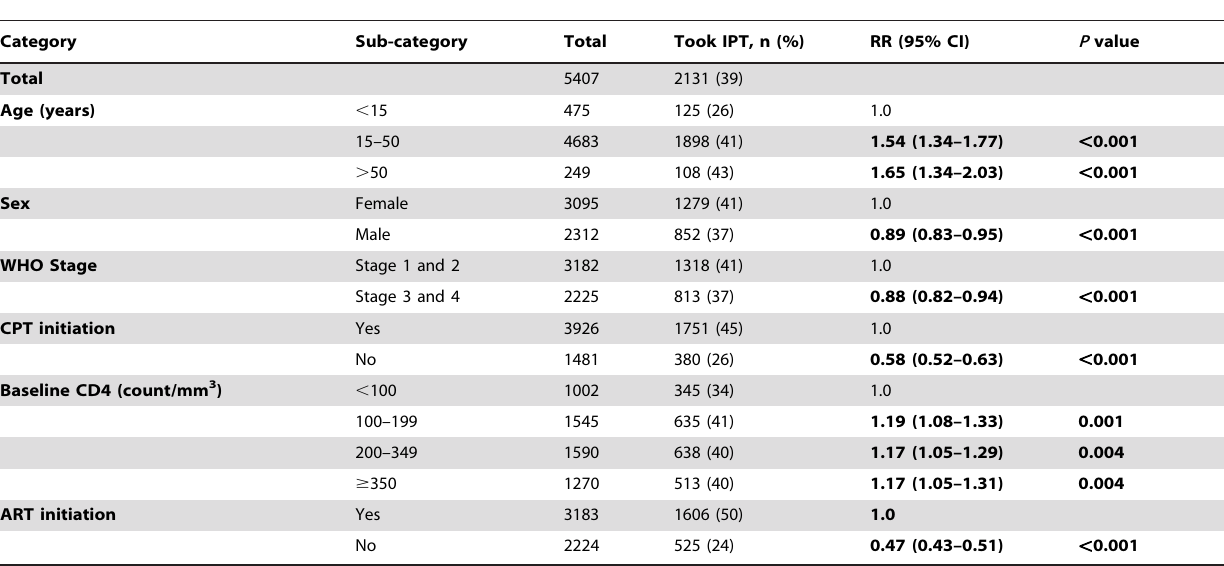
Table 2. Characteristics of HIV infected patients in Chronic HIV care who took IPT in SNNP region, Ethiopia, September 2007 to August